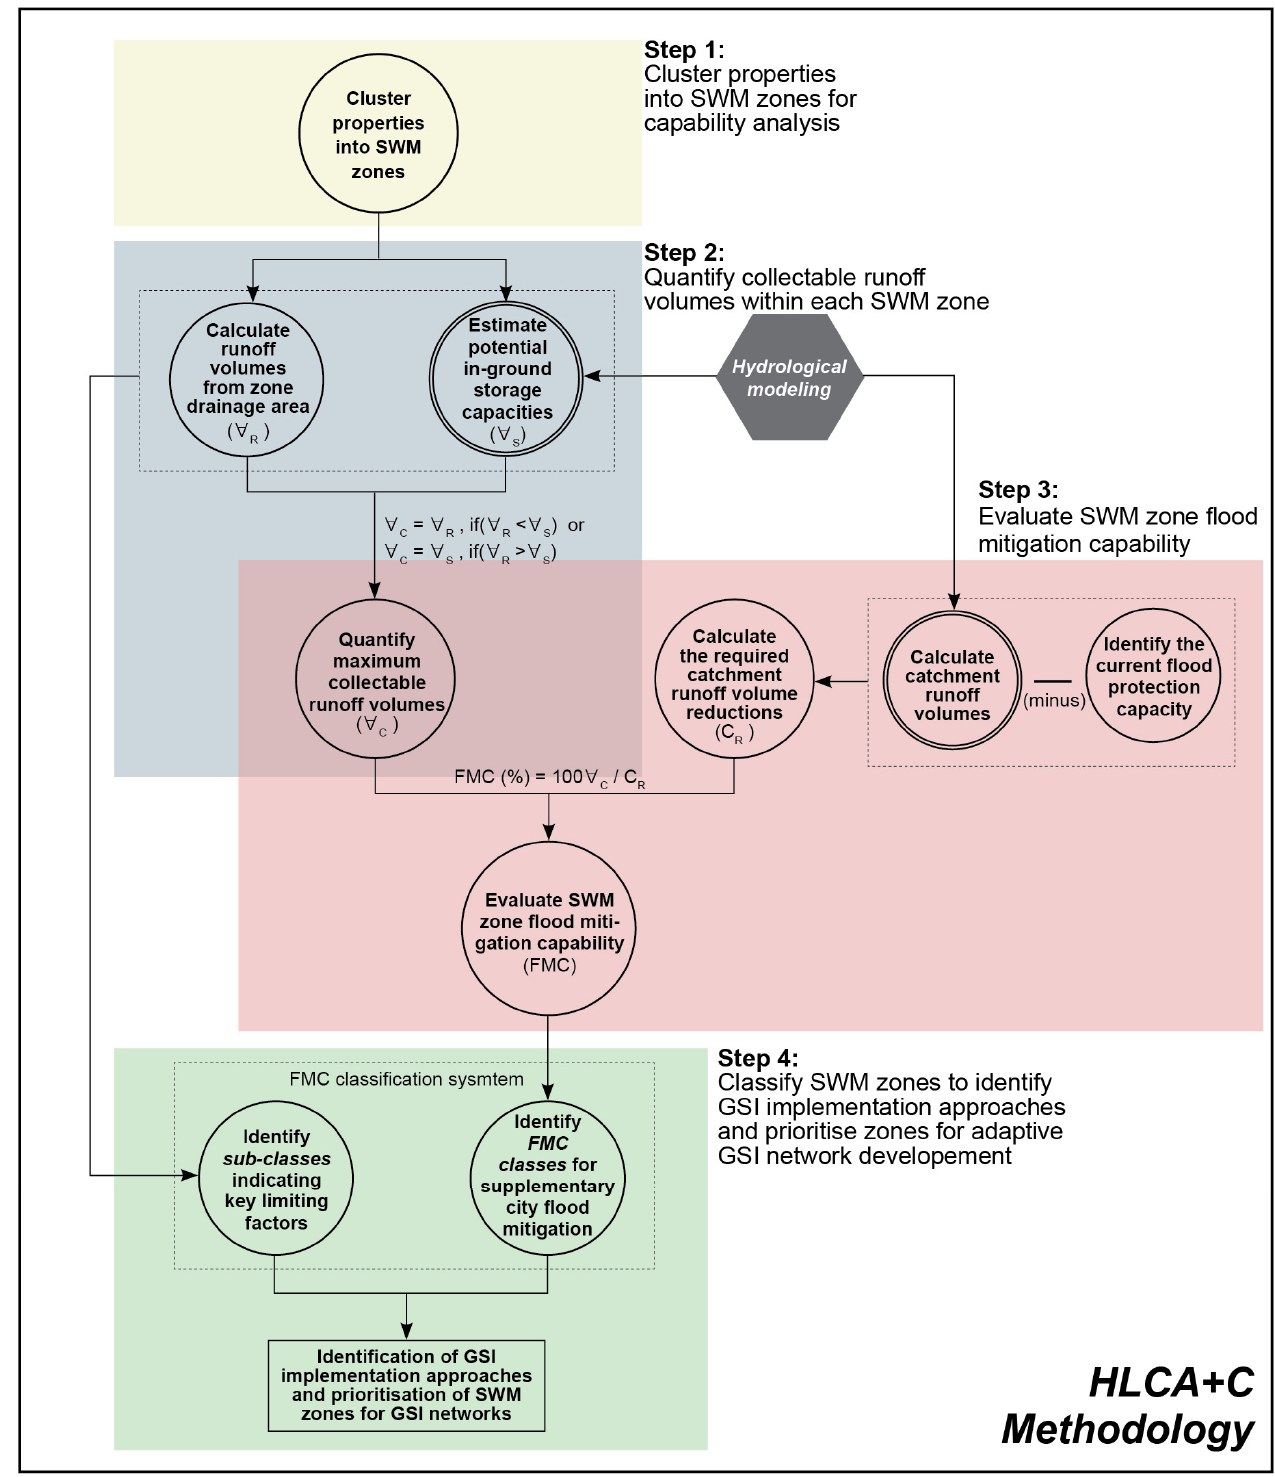
Figure 1. Four steps for evaluating and classifying Flood Mitigation Capabilities (FMC) of different Storm Water Management (SWM) zones in the context of climate change. Steps lead to the identifi- cation of implementation approaches and prioritisation of zones for GSI network implementation, which support the development of adaptation plans through time.